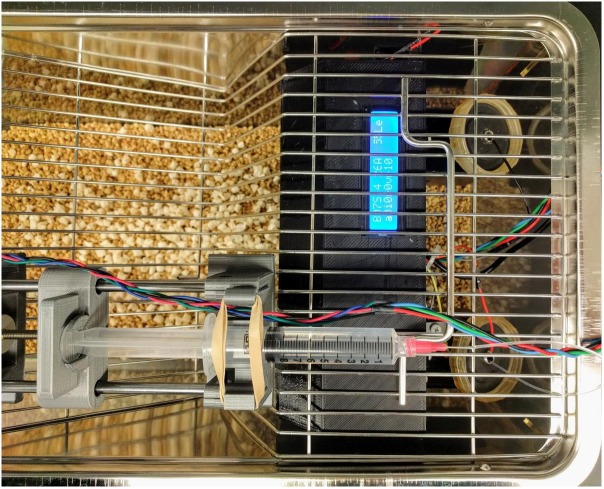
Operant licking device for oral alcohol self-administration. The device has a lick sensor that records licking events from both the active and inactive spouts. Licking on the active spout meeting a variable ratio schedule triggers the syringe pump to push one drop (60 μl) of alcohol to the tip of the spout. A visual cue (an LED) is turned on for 1 s with each reward. Licking on the inactive spout has no programed consequence.